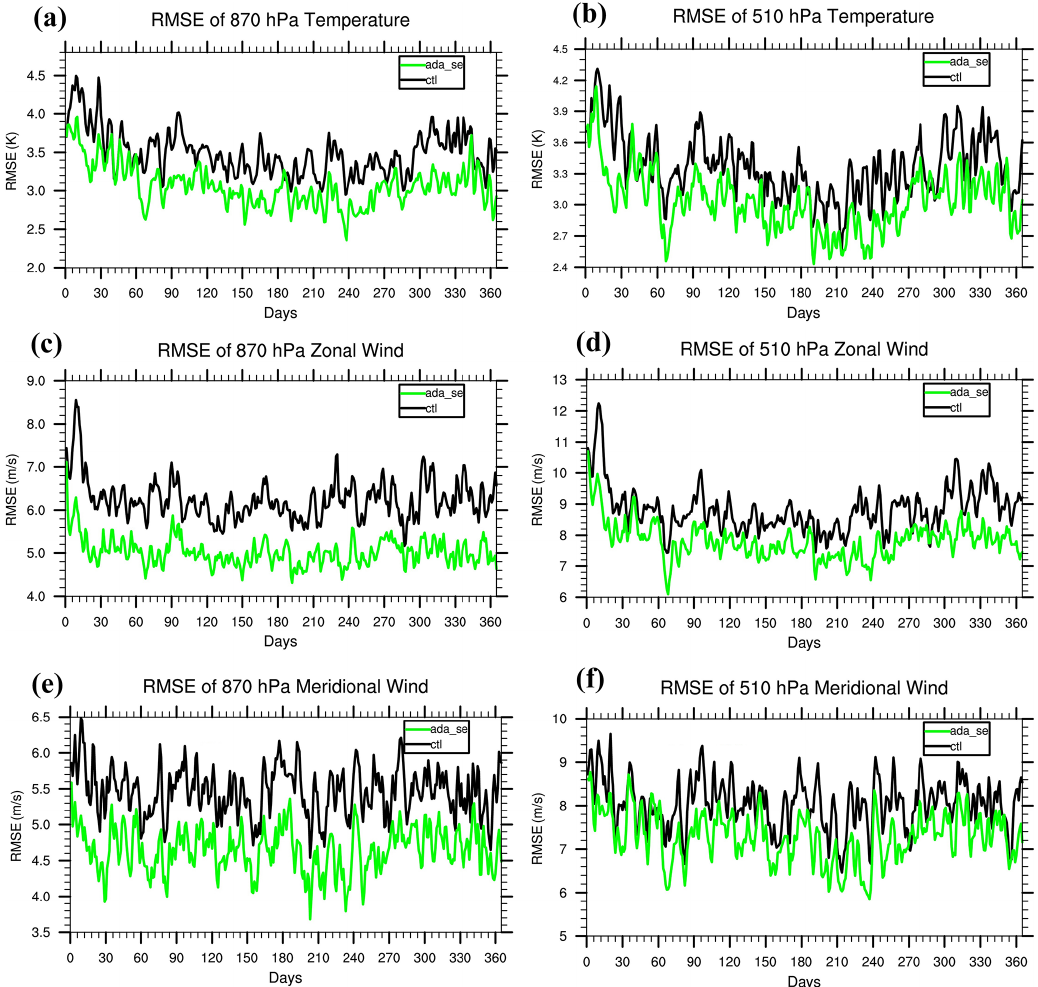
Figure 7. Time series of RMSEs of (a) 870hPa temperature, (b) 510hPa temperature, (c) 870hPa zonal wind, (d) 510hPa zonal wind, (e) 870hPa meridional wind, and (f) 510hPa meridional wind from ctl (black lines) and ada_se (green